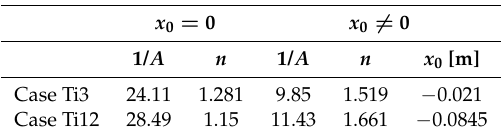
Table 4. Parameters of the fit of TI decay of LES to Equation (4). x 0 denotes the virtual origin of the curve with respect to the